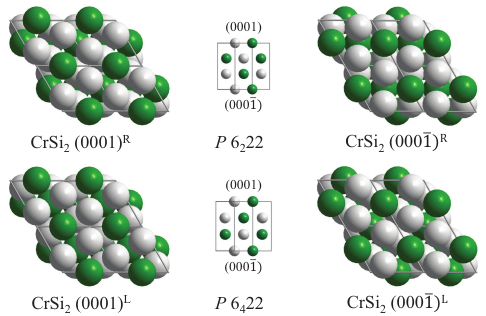
Figure 14. Different CrSi 2 (0001) surfaces and their (0001) counterparts. The upper row shows the right-handed and the lower row the left-handed crystal, with the indicated space group. The stacking order is sketched in the middle using [1120] as viewing